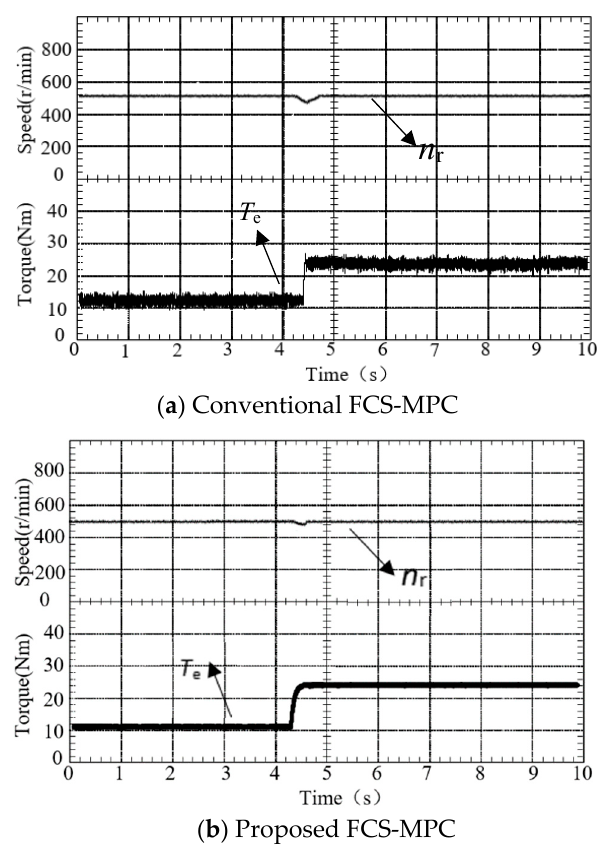
Figure 12. Speed dynamic and torque dynamic responses (SPMSM).